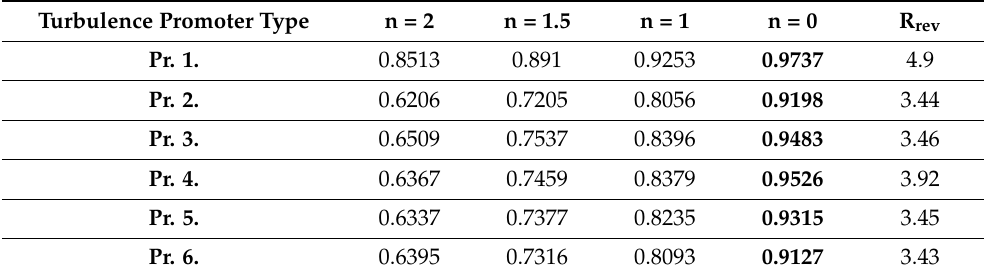
Table 4. R 2 values of Hermia model and reversible resistance ( NMWL = 150 kDa).